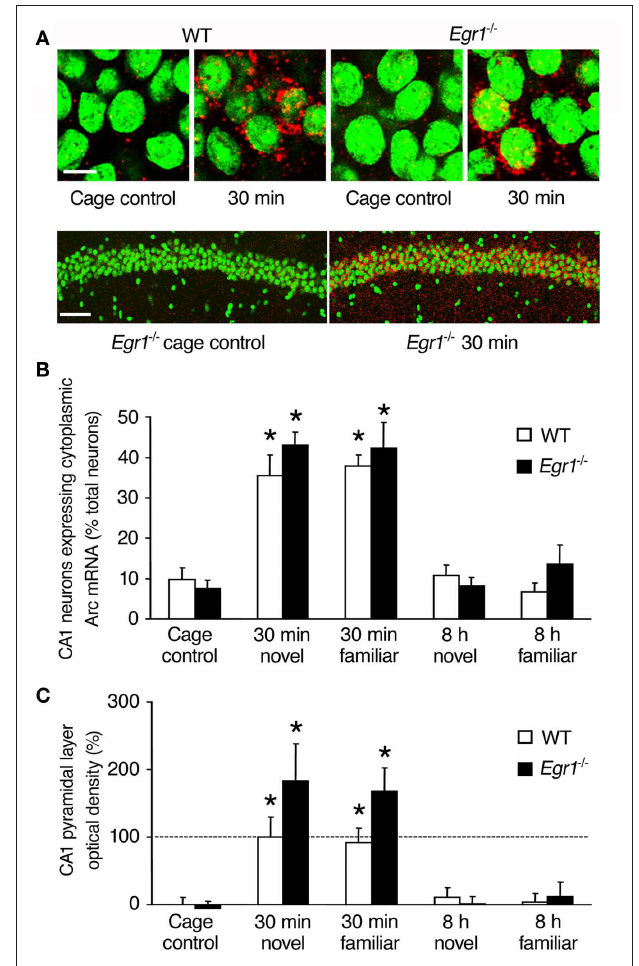
FIgure 3 | Arc mrNA expression after spatial exploration in CA1 of WT and Egr1 − / − mice. (A) Representative images from WT and Egr1 − / − cage control mice and 30 min after exploration of a novel or familiar environment. Scale bar, 10 μm. Below are sample lower definition images of Arc mRNA expression in CA1 from two Egr1 − / − mice (left: cage control; right: 30 min after spatial exploration). Scale bar, 100 μm. Cell nuclei appear in green (Sytox) and Arc mRNA signal in red (or yellow in the nucleus). (B) Proportion of the neurons expressing Arc mRNA in the pyramidal layer after exploration of a novel or familiar environment. (C) Normalized optical density of Arc mRNA signal in the pyramidal layer. Arc mRNA expression was similarly induced in WT and Egr1 − / − mice 30 min, but not 8 h following exploration. *Different from cage controls of the same genotype, at least p < 0.05. Dashed line indicates 100% (normalized to WT